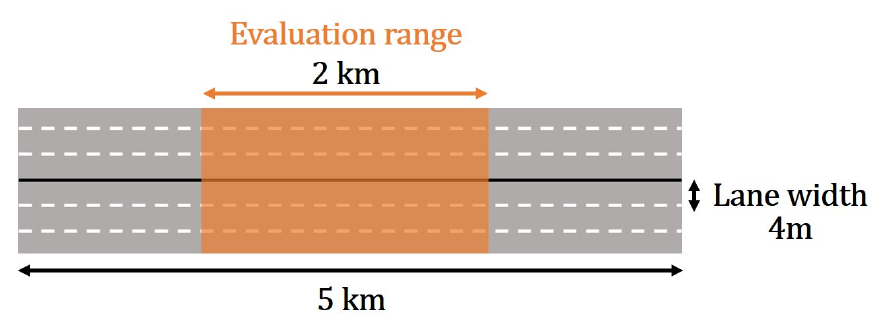
Figure 10. Highway